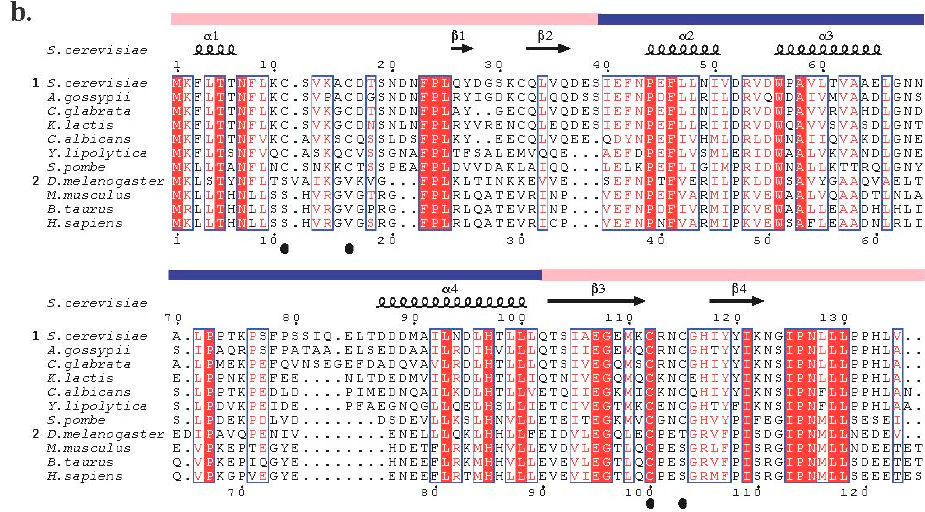
Figure 1. Organization of eukaryotic Trm112 proteins. ( a ) Ribbon representation of the crystal structure of isolated Saccharomyces cerevisiae Trm112 protein with a schematic representation of eukaryotic Trm112 shown below with the domain’s color code. ( b ) Sequence alignment of eukaryotic Trm112 protein sequences. Amino acids forming the Zn-knuckle and helical domains are identified by pink and blue bars, respectively, above the sequences. The positions of the four cysteine residues coordinating the zinc atom in the structures of fungal and Encephalitozoon cuniculi Trm112 proteins are indicated by black spheres below the alignment. Secondary structure elements as observed in the structure of the S. cerevisiae Bud23-Trm112 complex are indicated above the sequences [20]. Sequences have been divided into two subgroups: fungal proteins (Subgroup 1) and metazoans (Subgroup 2). Strictly-conserved residues are in white on a red background. Strongly-conserved residues are in red. This figure was generated using the Espript server [22]. C-ter: C-terminal protein extremity; N-ter: N-terminal protein extremity.